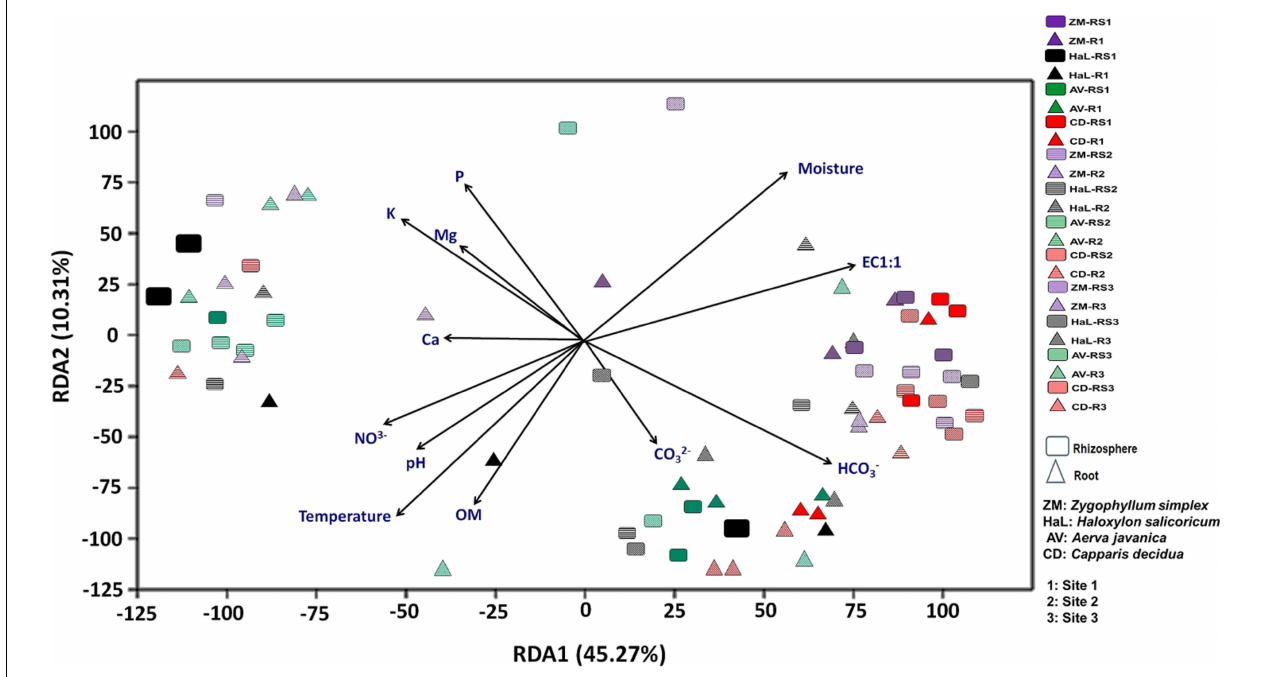
FIGURE 1 | Environmental fitting analysis of rhizosphere and root endosphere microbiomes across the three sites by using redundancy analysis (RDA) plot.